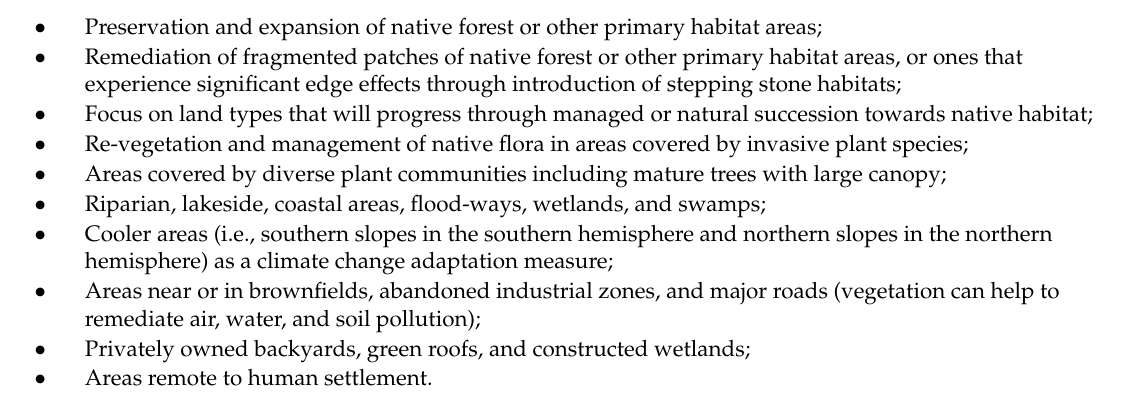
Table 7. Priorities for areas that should be dedicated to urban habitat